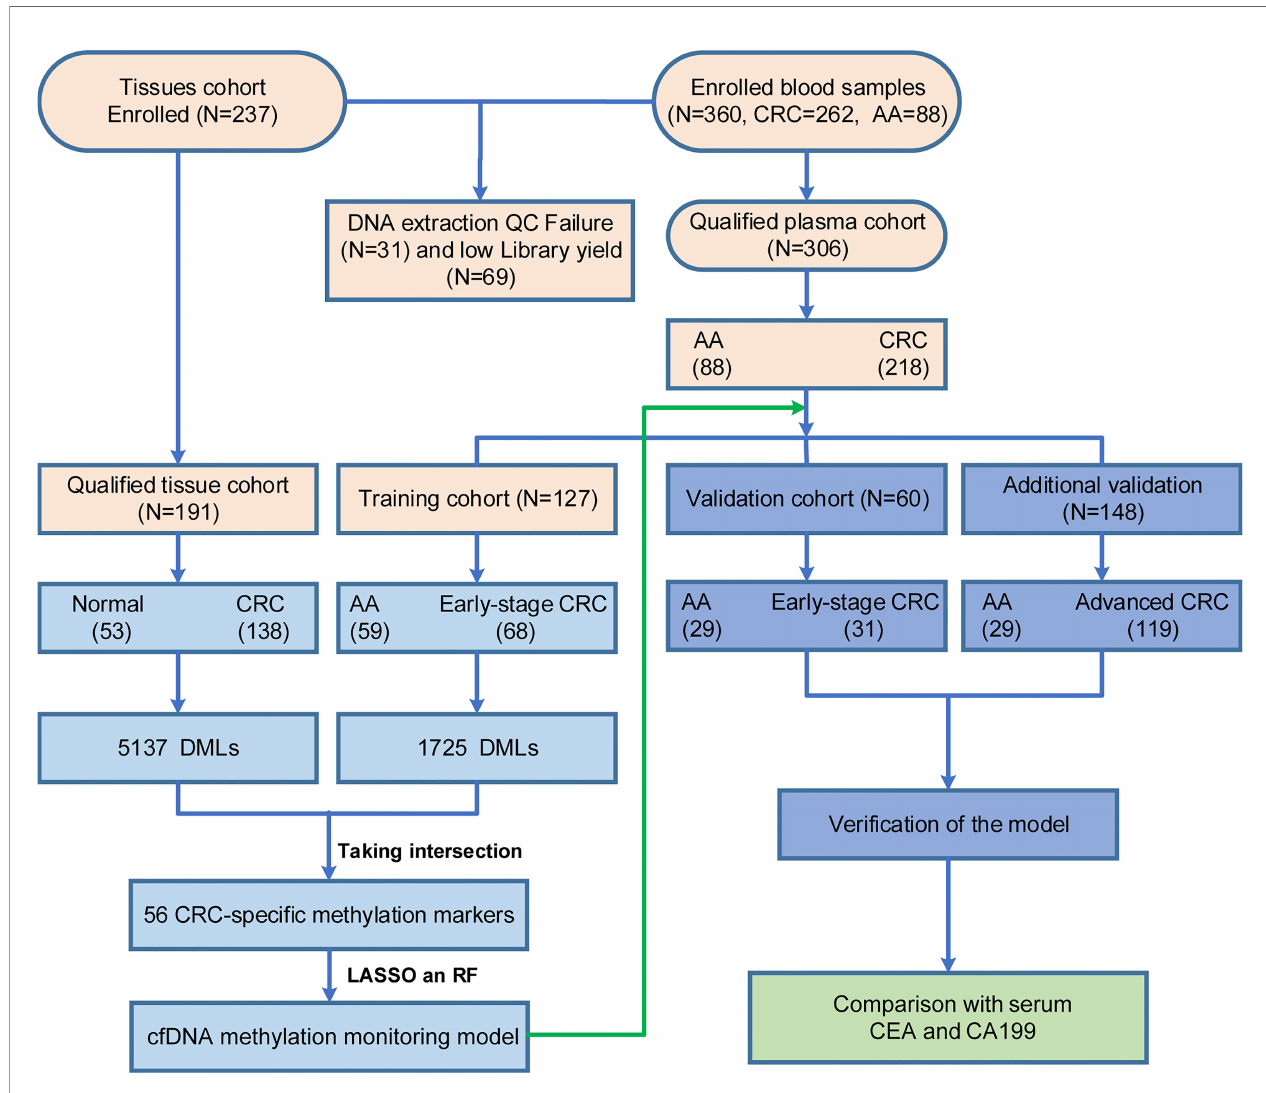
FIGURE 1 | Enrollment of a retrospective study cohort and work fl ow for building the methylation monitoring model with seven biomarkers. Light orange: quality control of tissues and blood samples; Light blue: construction of the SDMBP model; Purple: veri fi cation of the SDMBP model in the training cohort and additional independent cohort; Green: CRC screening performance comparison of the SDMBP model with quanti fi cation of the levels of serum CEA and CA199; The validation and additional validation cohort included the same 29 AA